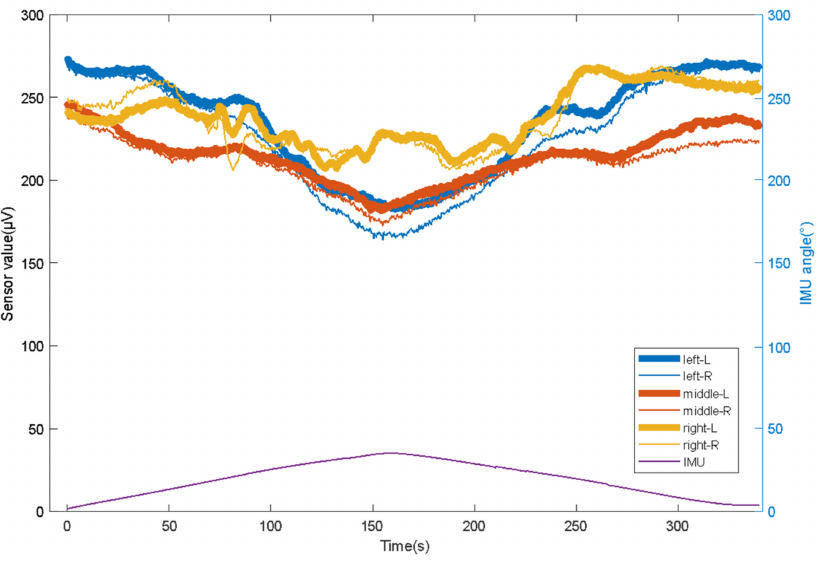
Figure 18. The relationship between the head swing angle and the sensor value change.